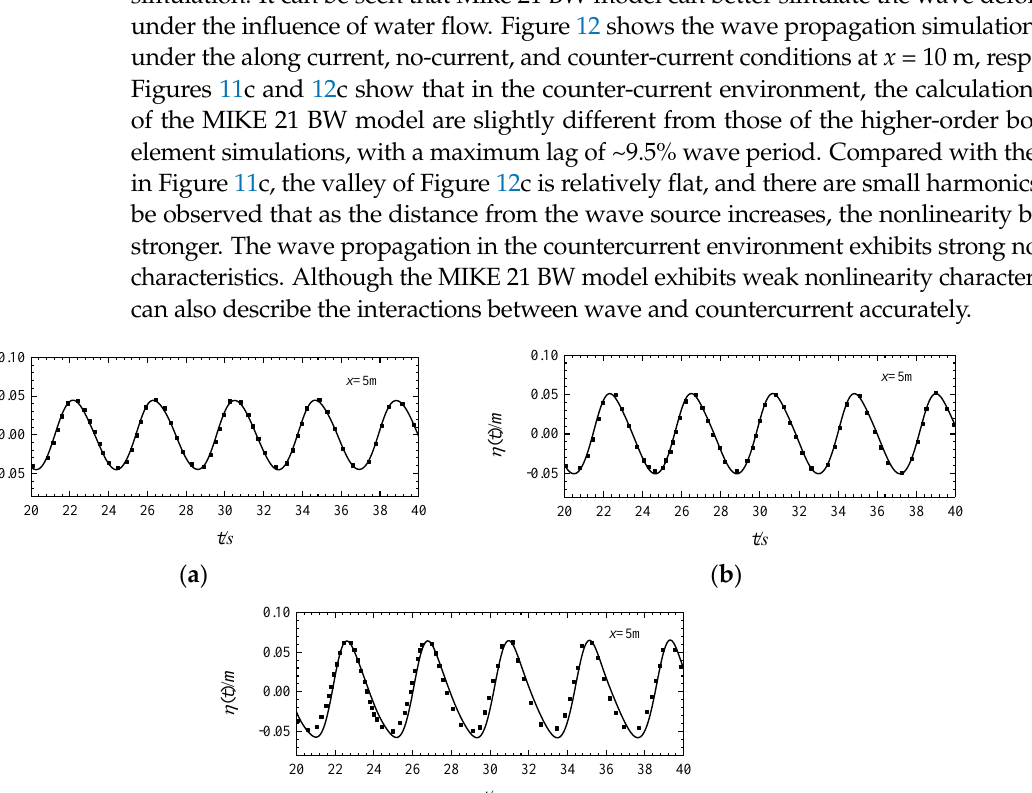
( b ) ( c ) Figure 12. Wavefront ratio (at x = 10 m) of the MIKE 21 BW model (solid line) to the boundary element model ( ■ ) in downstream ( a ), no-current ( b ), counter-current ( c ) environment. Figure 13 shows that the wave deforms subject to the influence of the current. The wave amplitude decreases subject to the action of the downstream current and increases subject to the action of the counter current. The comparison of the numerical simulation results of the downstream, no-current, and countercurrent environments, shows that the wave exhibits an obvious phase deviation, which indicates that the wave speed changes subject to the action of the current. Thus, this indicates that the wavelength, respectively, increases and decreases subject to the downstream and countercurrent environments.